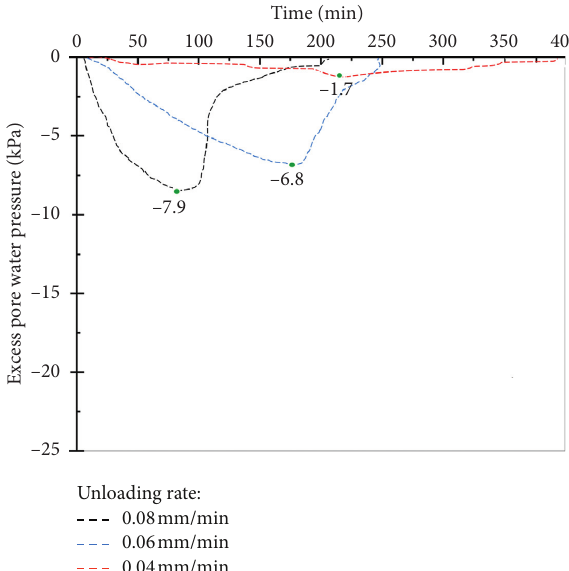
Figure 10: Curves of excess pore water pressure values with time under different unloading rates at a confining pressure of 219kPa.